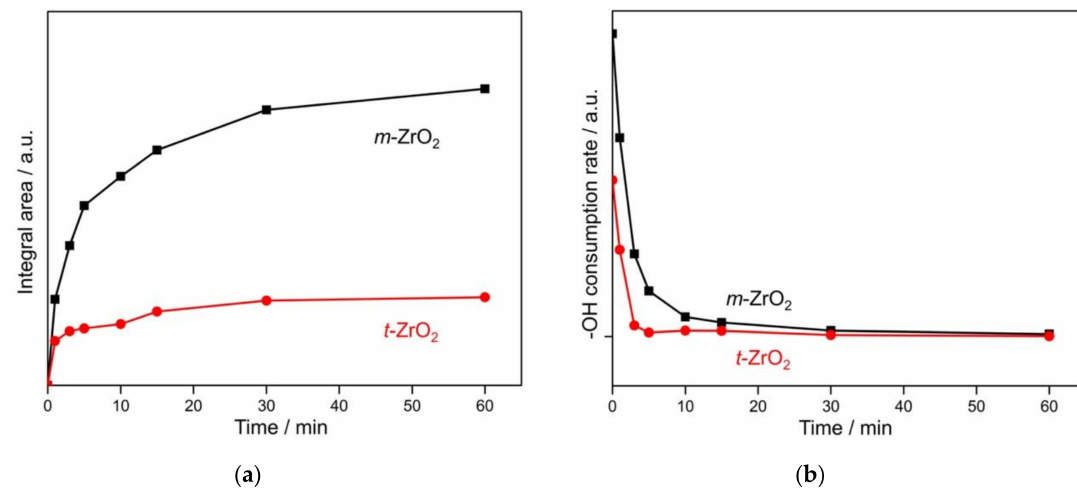
Figure 4. Integral area of –OH peaks ( a ) and the –OH consumption rate ( b ) over the ZrO 2 samples.